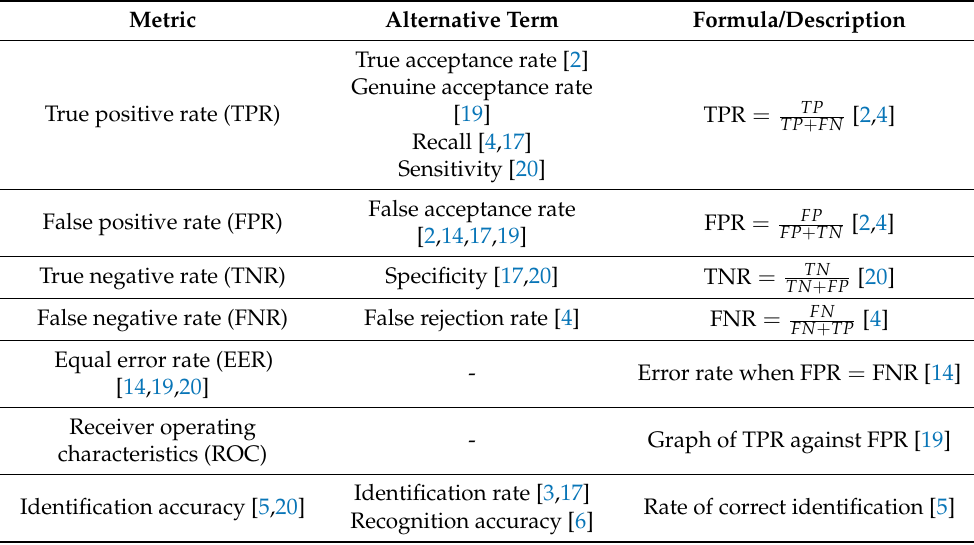
Table 2. A summary of the evaluation